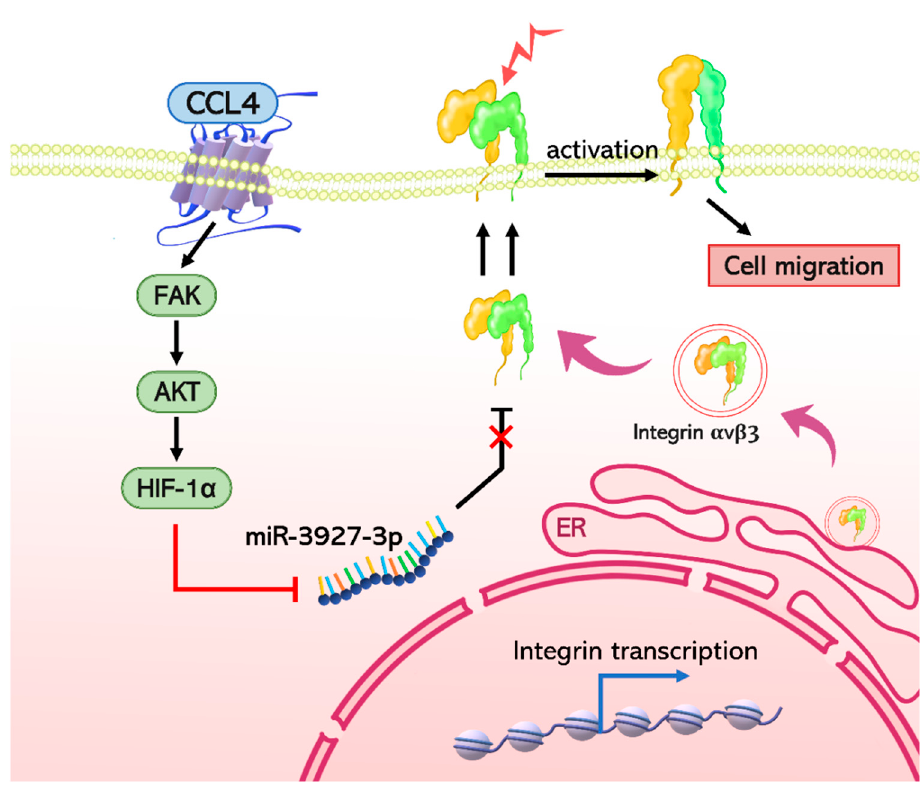
Figure 8. The schema depicts the involvement of signaling pathways in CCL4-induced stimulation of integrin α v β 3 expression and cell migration.